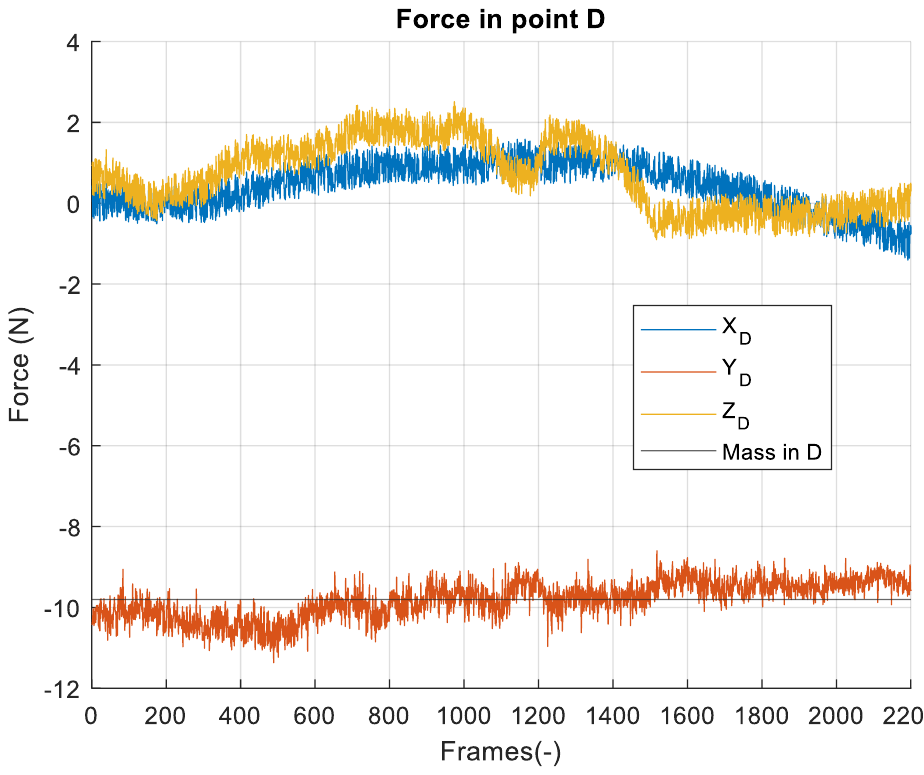
Figure 8. Calculated force at the end of the robot with a mass of 1 kg.